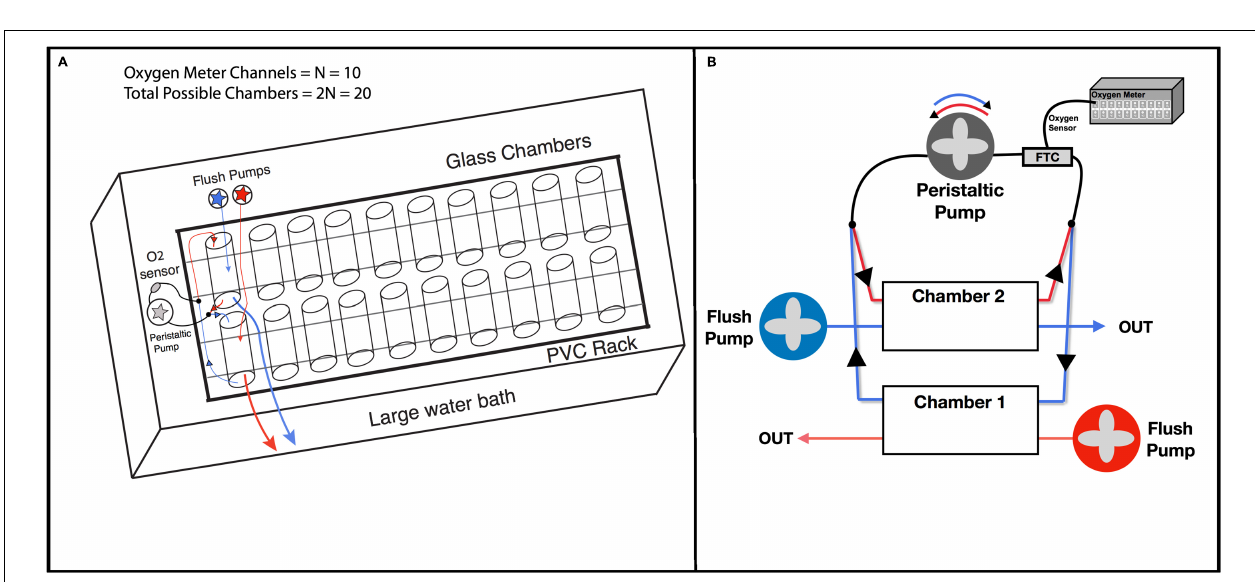
FIGURE 1 | Intermittent flow respirometry. Oxygen concentration over time in a chamber during intermittent flow respirometry. There are two period types: Measurement and Flush. Measurement periods (gray shading) occur when the chamber is sealed, and the decrease in oxygen concentration reflects oxygen consumption by the organism. The slopes of the lines (oxygen vs. time) during the measurement periods are used to calculate metabolic rate. Flush periods are when the rapid increase in oxygen occurs as fully oxygenated water is pumped into the chamber. Data displayed are from the setup described here.